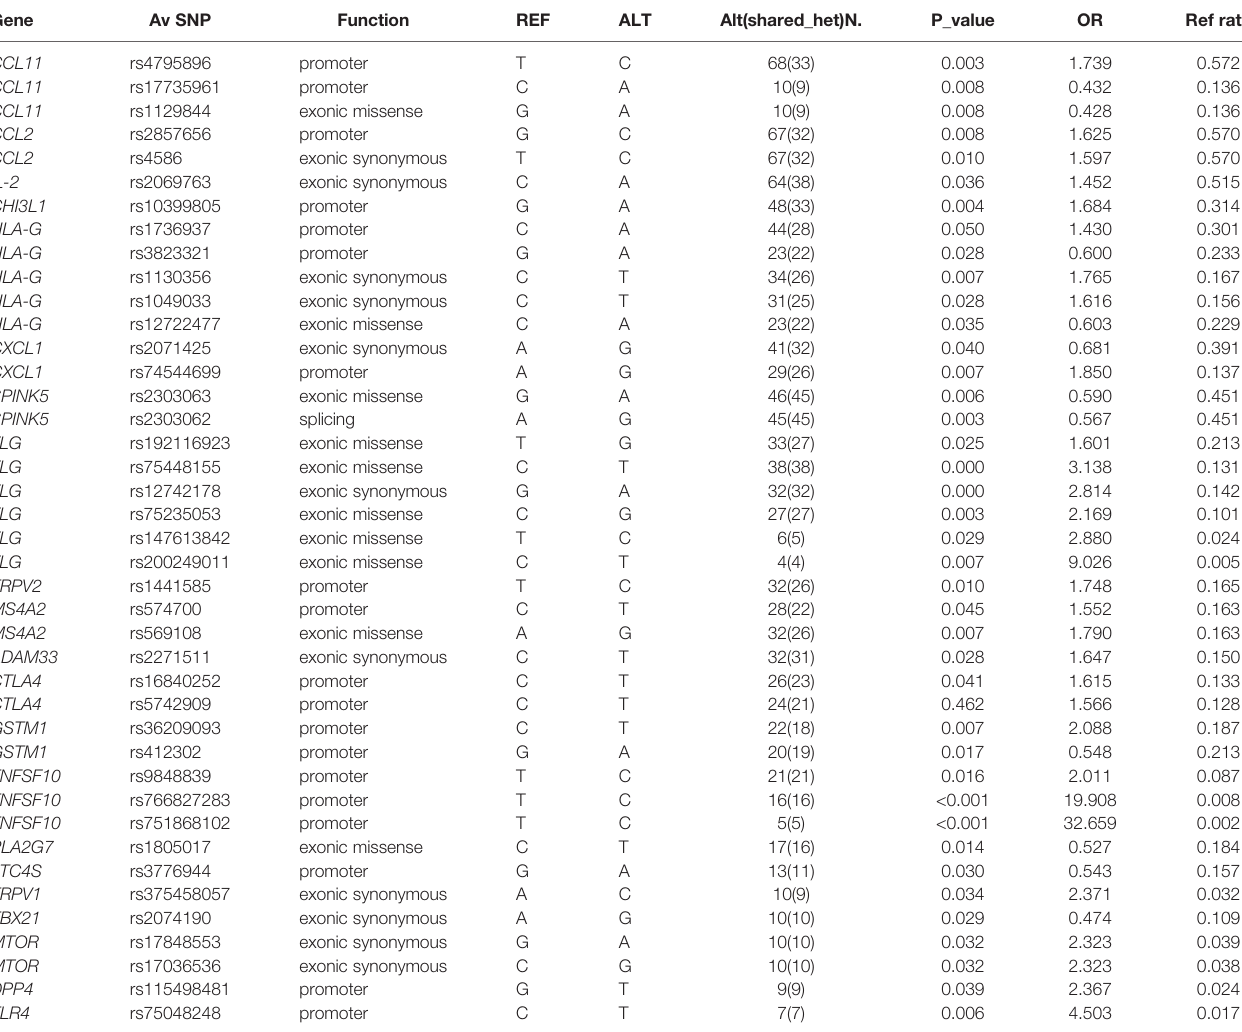
TABLE 2 | Screened SNP list of EA patients.